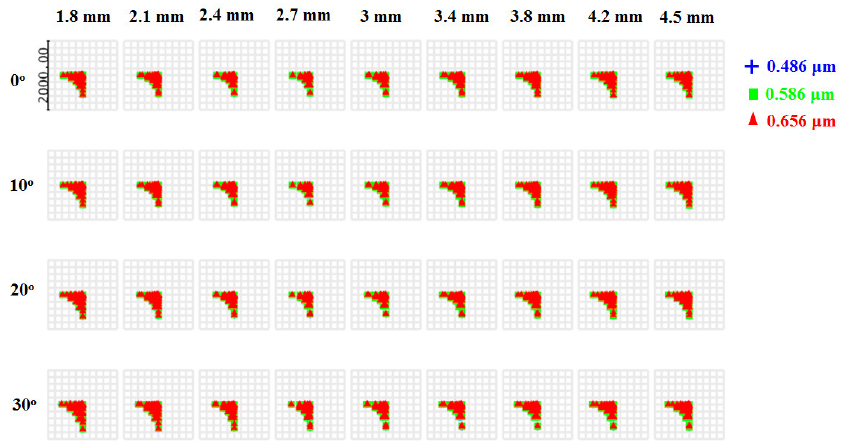
Figure 9. Spot diagrams of the optical endoscope with phase mask, varied by different object distances and FOVs. Each column stands for the same object distance (e.g., 1.8 mm), and each line stands for the same FOV (e.g., 0 ◦ ). The blue cross, green square and red triangle represent the 0.486 µ m, 0.586 µ m and 0.656 µ m incident